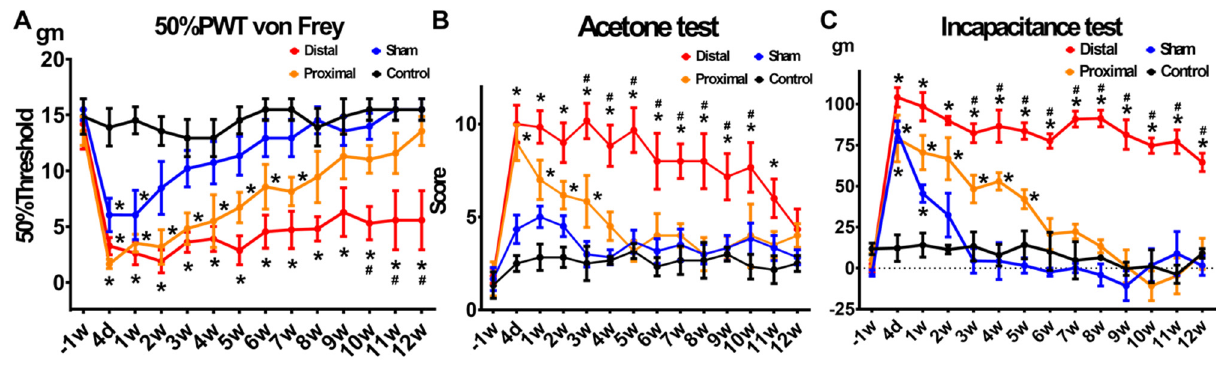
Figure 2. Pain behaviors in animal models of lumbar radiculopathy. ( A ) 50% paw withdraw threshold von Frey test, ( B ) acetone test, and ( C ) weight-bearing test of animals with distal nerve constriction (Distal), proximal nerve constriction (Proximal), sham operation (Sham), and naïve (Control). Data are mean ± SEM, N = 6 rats in each group. * p < 0.05 vs. Control, # p < 0.05 vs. Proximal, scale bar = 50 μ m.